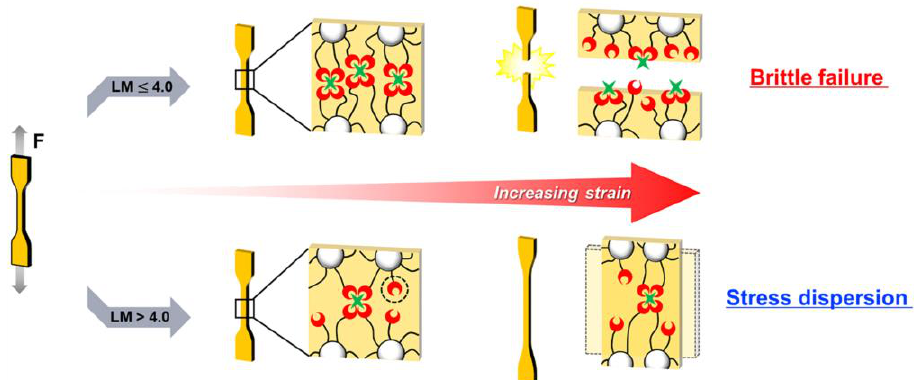
Figure 28. Schematic illustration of the influence of L/M ratio on the mechanical response under tensile tests. Reprinted from Mater. Today Chem . 2021, 22 , Sasaki, Y.; Yamamoto, T.; Mori, H., Mechanically robust, ion-conductive, self-healing glassy hybrid materials via tailored Zn/imidazole interaction, 100611, [92]. Copyright (2021), with permission from Elsevier.